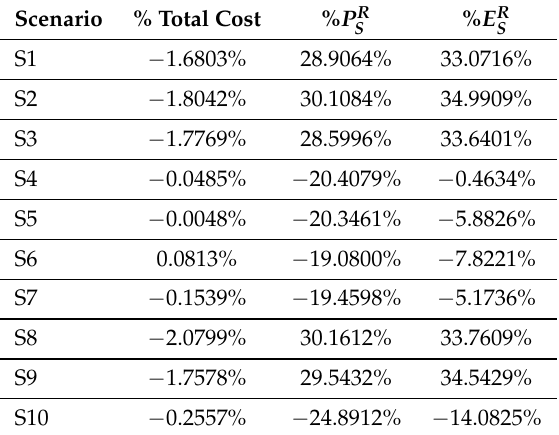
Table 7. Comparison of results of all scenarios with SP solution.